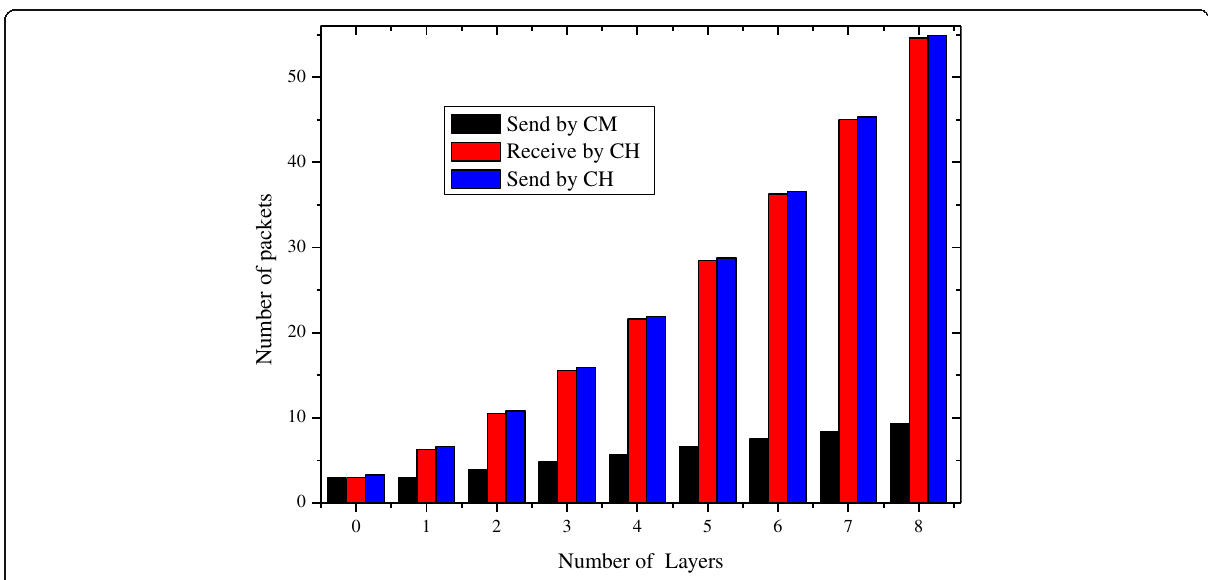
Fig. 7 The number of packets without DEEDC